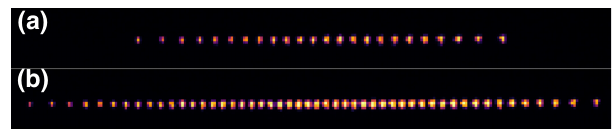
FIG. 19. Ion images of (a) 24 and (b) 50 ions in the demon- strator. The 24-ion chain is used to demonstrate 24-partite entan- glement within the setup without the use of postselection or error mitigation. Fifty-ion chains are the midterm control target and can already be trapped and cooled. Nonuniform brightness stems from the finite size of the detection